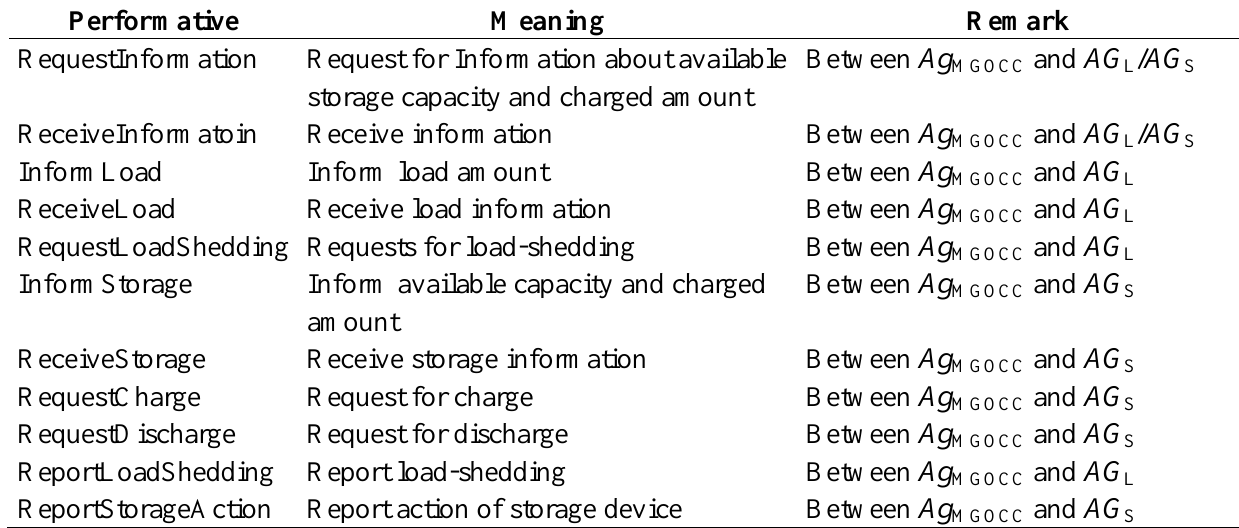
Table 2. Performative for